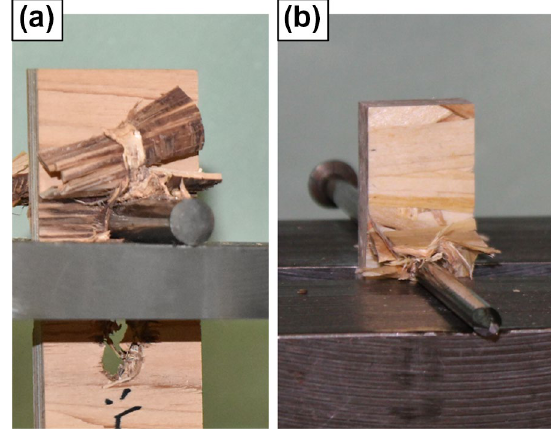
Fig. 6 Partial buckling failure. a PW-w and b OSB-w. The other parameters for PW-w were as follows: d dowel position F. The other parameters for OSB-w were as follows: = d 5.2 mm, ph 0, and dowel position = =